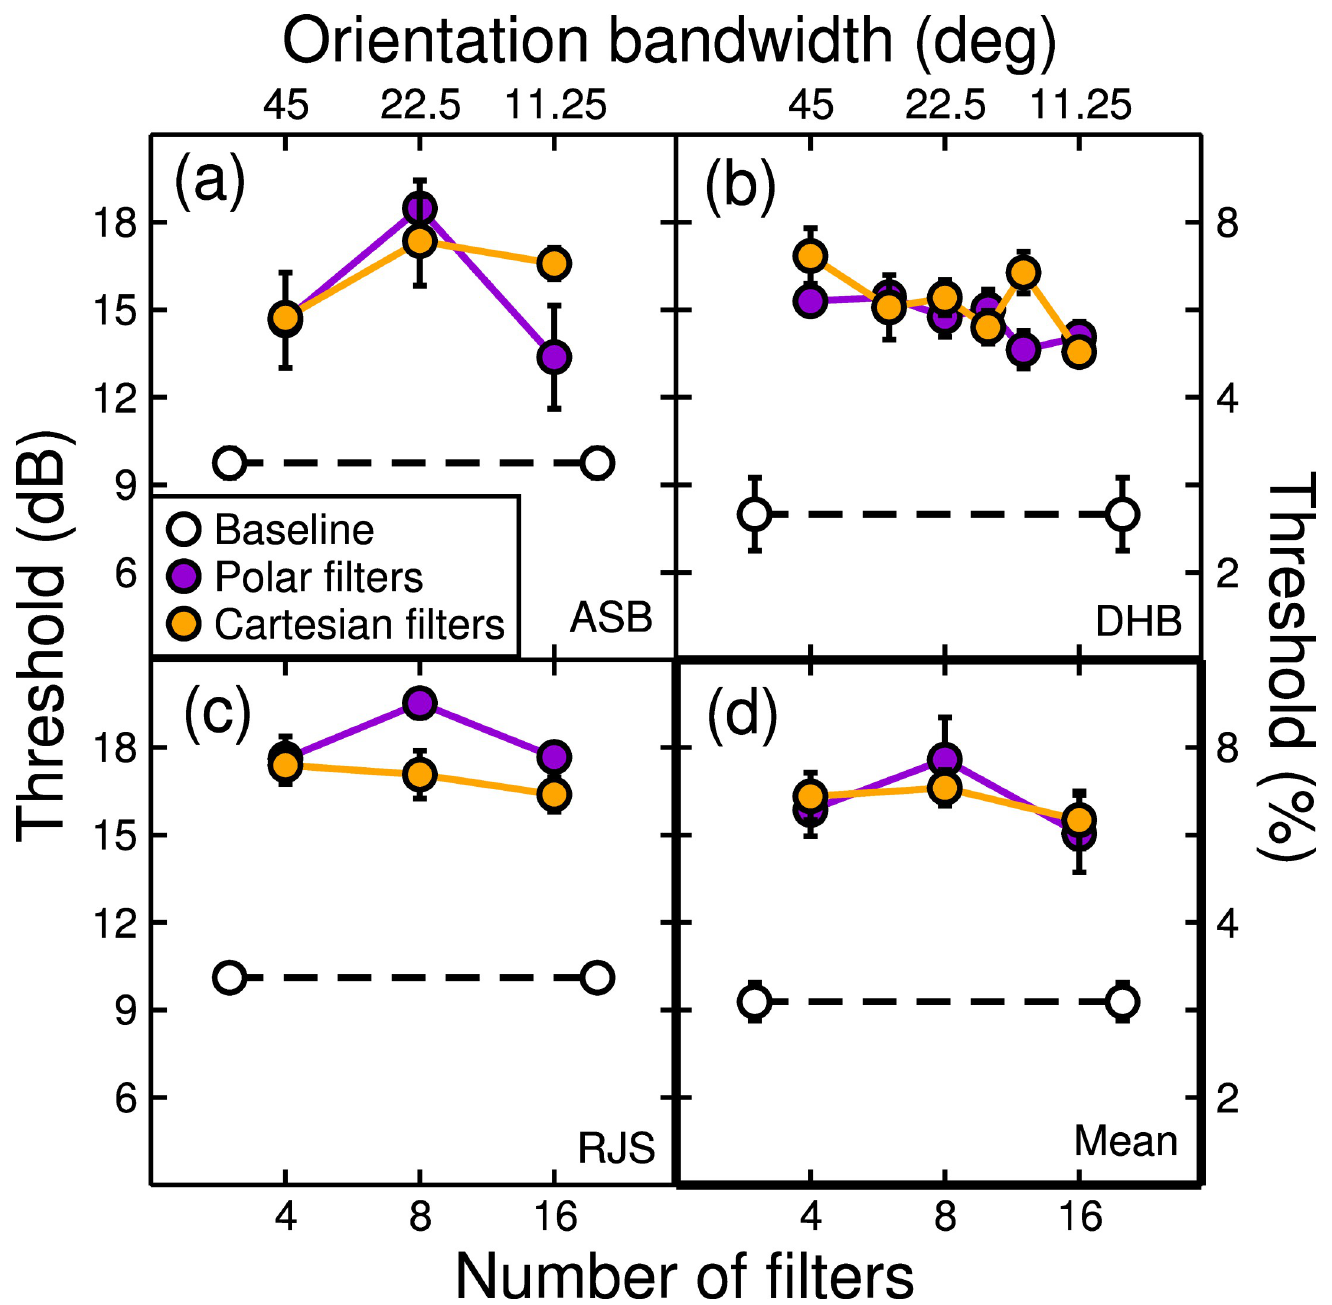
Fig 6. Thresholds for individual observers (a-c) and their average (d). Each point is the average of four repetitions (a total of around 420 trials) of the experiment (a-c) or three observers (d), with error bars giving ± 1SE of the mean. White symbols are contrast thresholds for detecting which of a pair of images had white noise added to it. Coloured symbols are thresholds for the same task, but after passing all images through a denoising algorithm. Thus, the difference between white and coloured symbols indicates the amount of visible noise removed by the algorithm, which on average was around